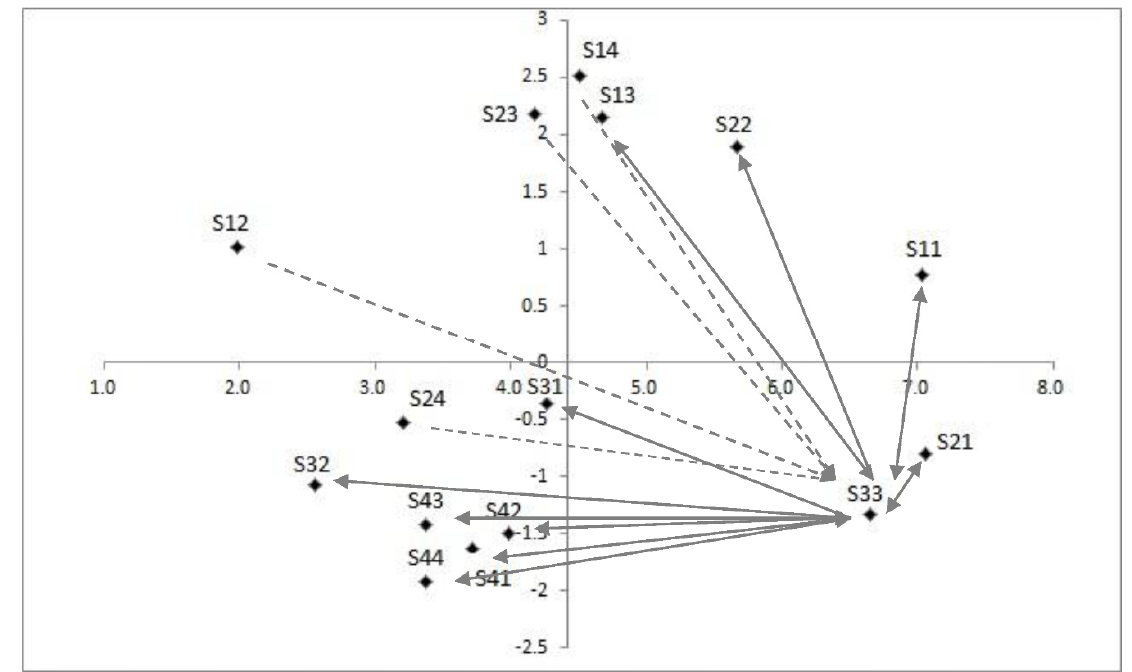
Figure A11. Casual Diagram between S33 and Other Criteria.